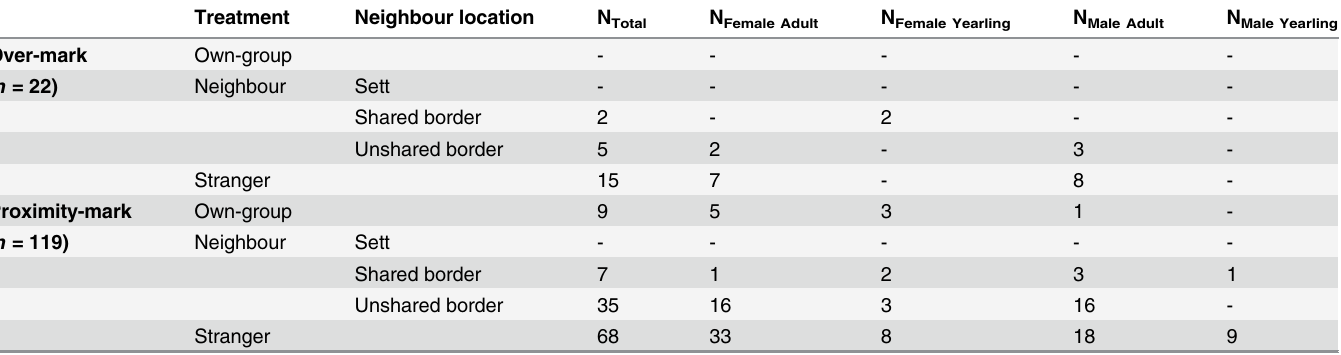
Table 2. Subcaudal over-marking (i.e., marking on top of the introduced AGS), and proximity-marking (i.e., within 50cm) in response to different levels of familiarity (own group, neighbour, stranger), spatial-context (sett, shared border, unshared border) and sex of donor ( n = 141).